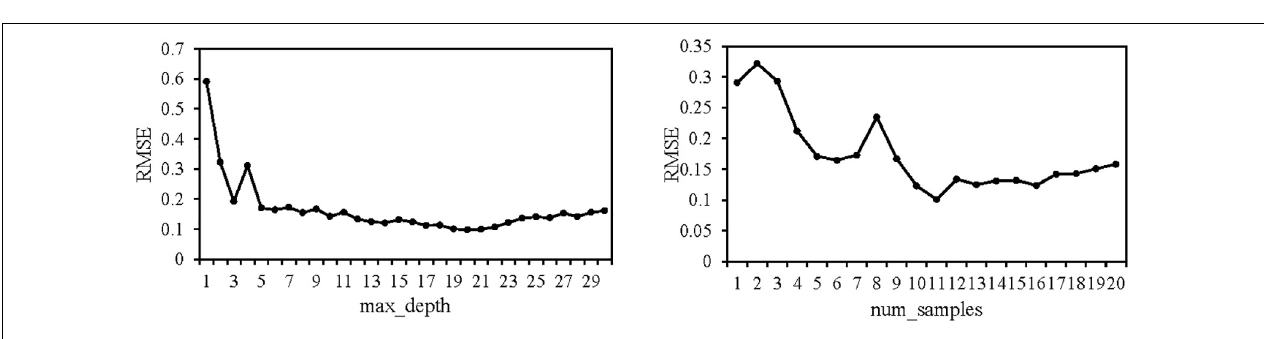
FIGURE 2 | Sensitivity of CART parameters on the RMSE.